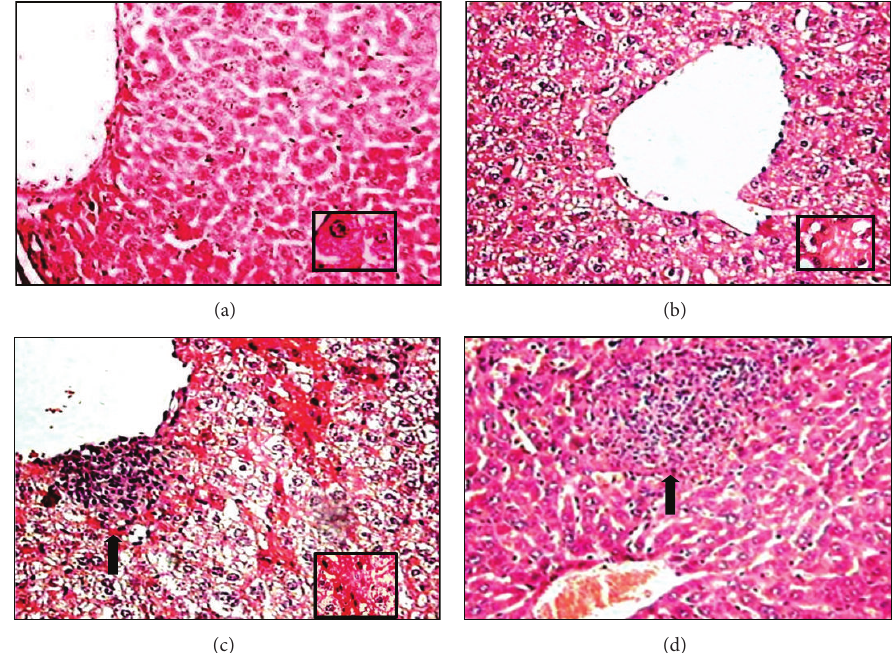
Figure 3: Liver histological analysis of mice exposed to diphenyl ditelluride 50 𝜇 mol/kg for 7 days. (a) Liver section of control group showing polygonal hepatocytes with oval shaped nuclei, dispersed chromatin, and prominent nucleolus cordially arranged towards hepatic central vein (detail in 40x); (b) liver section of diphenyl ditelluride treated mice showing hepatocytes with manifestation of hydropic degeneration (detail in 40x); (c) pyknotic nuclei and eosinophilic cytoplasm (arrow) (detail in 40x) and (d) mononuclear infiltrate in centrilobular (zone 3) and mediolobular (zone 2) (arrow) areas (H&E 10x). The picture is a representation of three independent